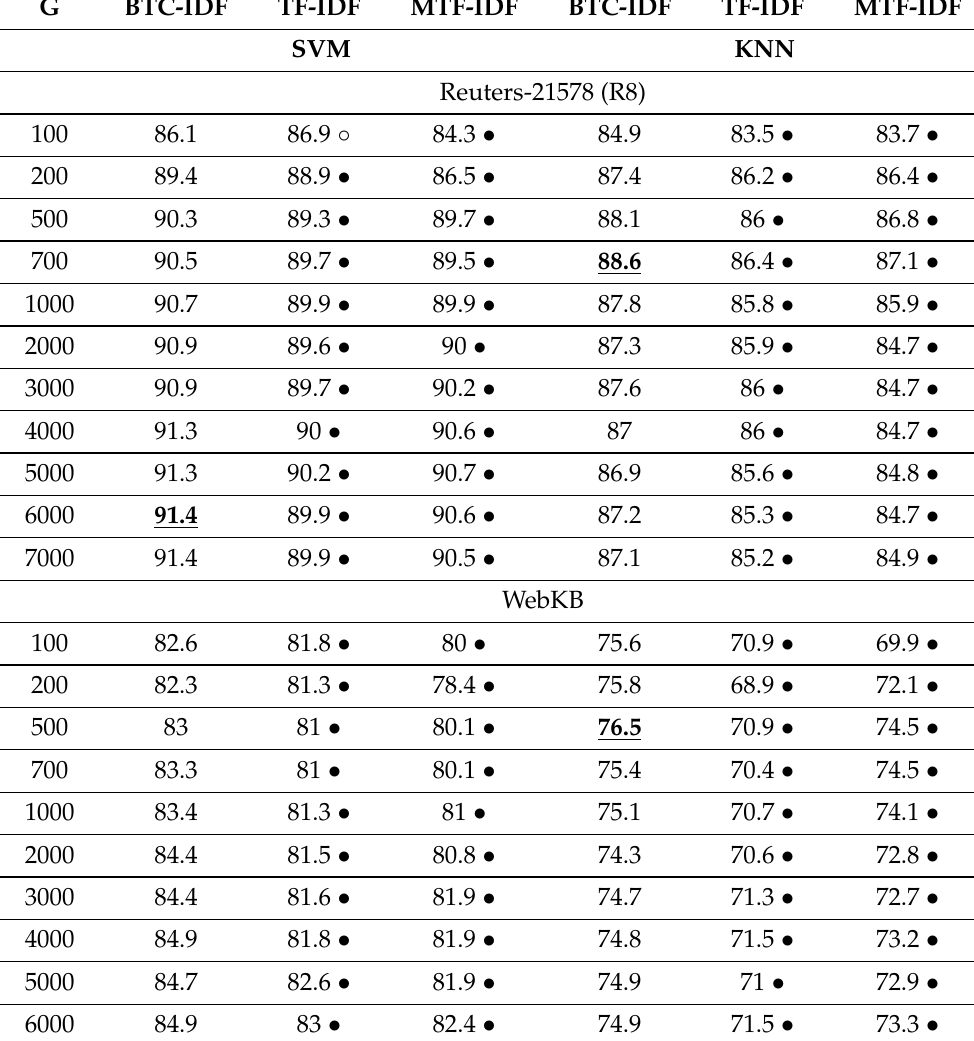
Table 6. Performance comparison of BTC-IDF vs TF-IDF vs